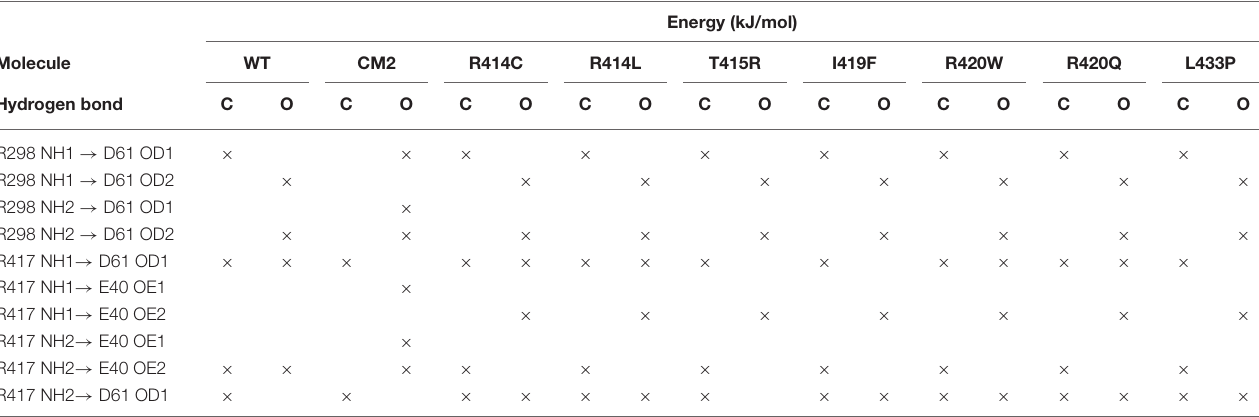
TABLE 3 | Hydrogen bonding network R298-E40-R417-D61 of the wild type and mutant NTR in the closed and open